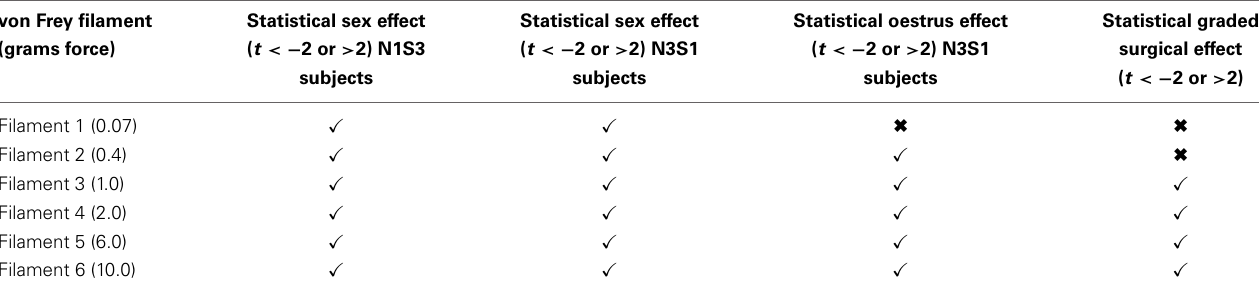
Table 8 | The ability of von Frey test 3 to estimate differences in allodynia for diverse covariates across individual von Frey